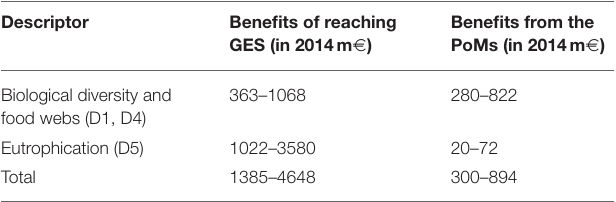
TABLE 4 | Estimated benefits of implementing PoMs and achieving GES in Finnish marine waters.